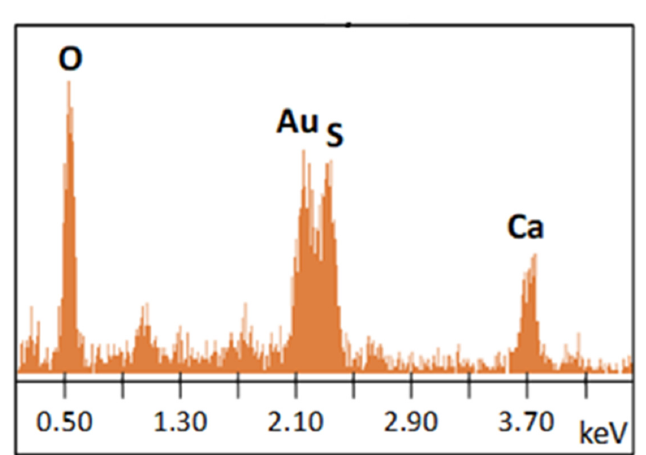
Figure A1. EDS spectra of MMS membrane fouled/scaled after 14 h of filtration with raw